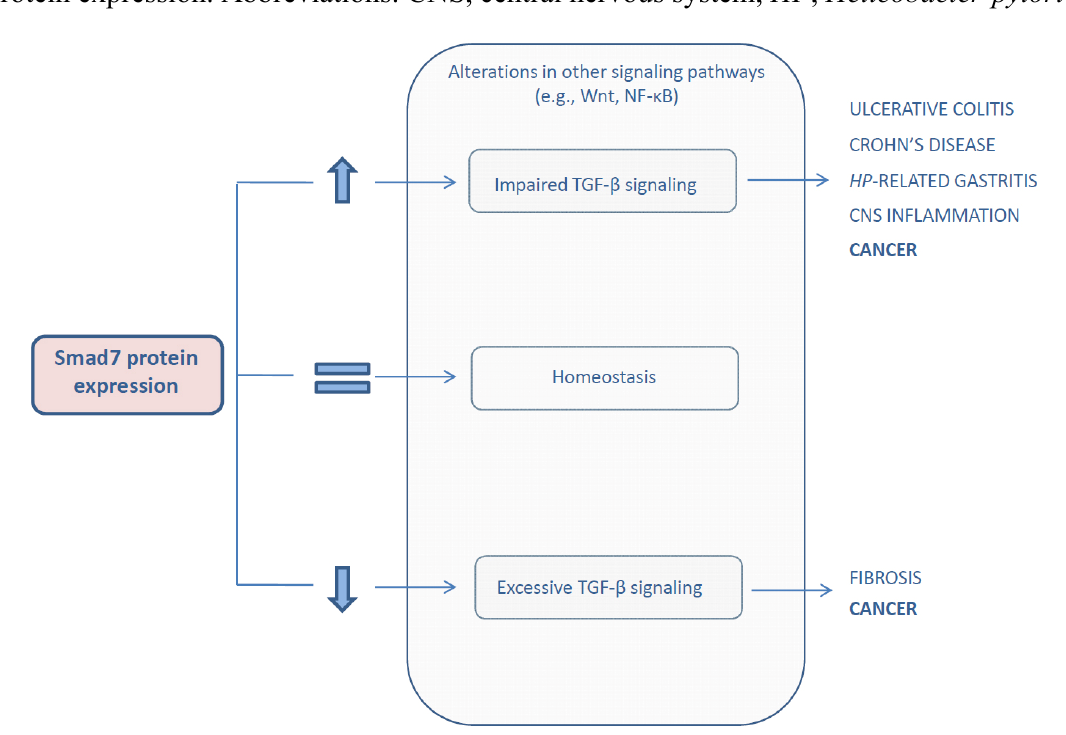
Figure 2. Schematic overview depicting the pathogenic roles of a deregulated